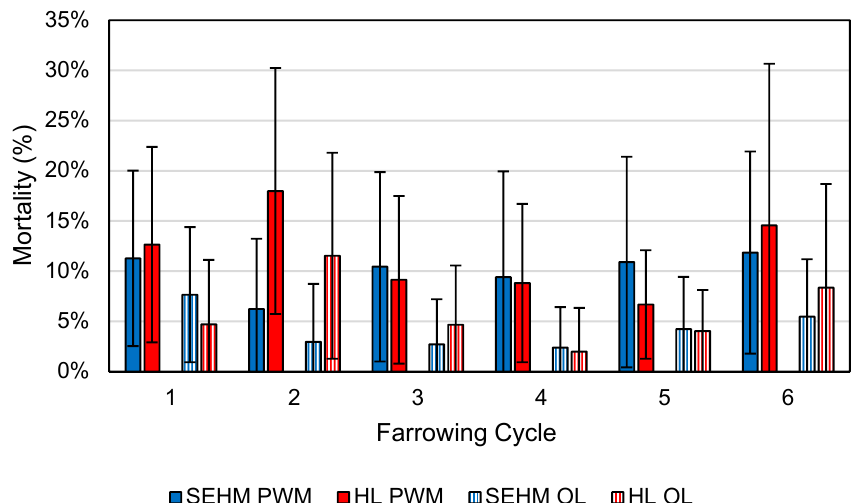
Figure 9. Pre-weaning mortality (PWM) and over-lay mortality (OL) percentages over six farrowing cycles for the two heat source treatments, SEHM and heat lamp (HL). Error bars represent one standard deviation of the farrowing cycle mean. This data represents the raw results, and thus, no statistical analysis between cycles was performed.